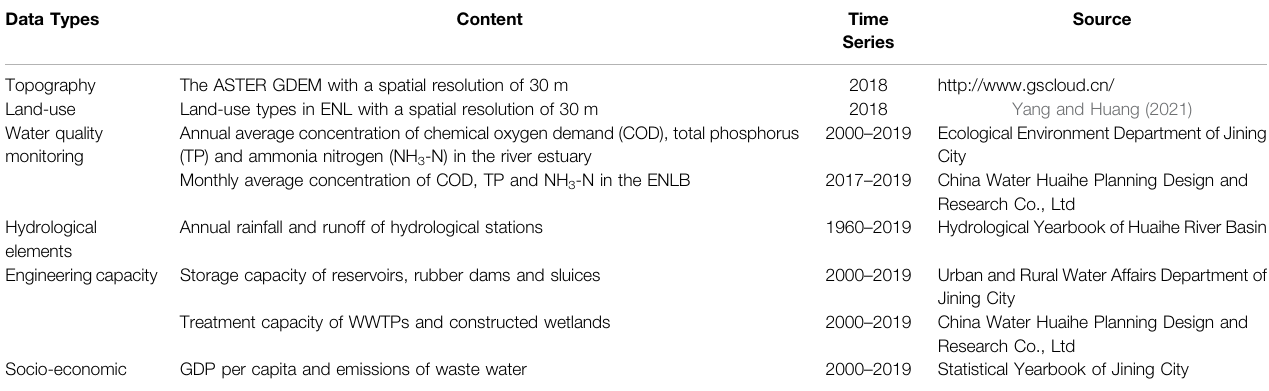
TABLE 1 | Information on the data